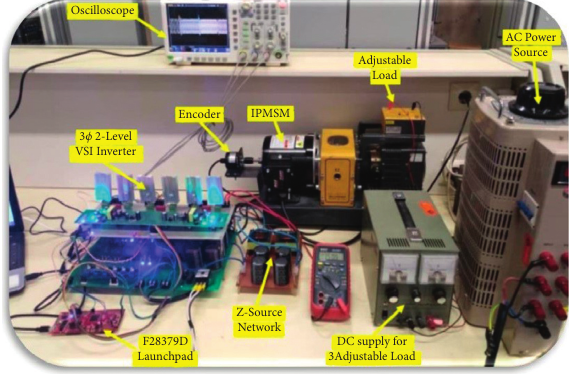
Figure 5: The setup of the PMSM control system.